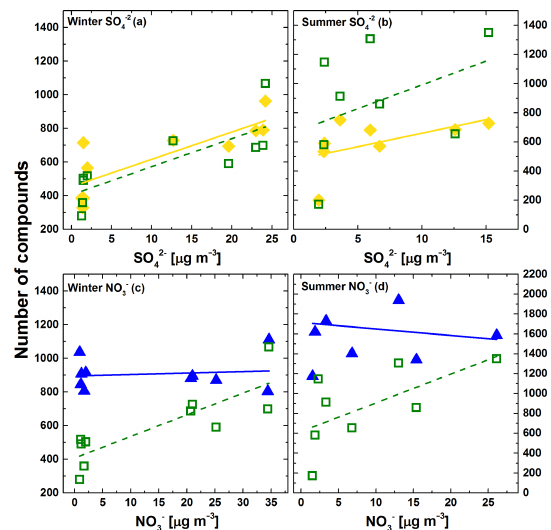
Figure 8. Number of molecular formula with the elemental composition CHOS (yellow diamonds), CHONS (green square) and CHON (blue triangles) plotted against the concentration of (c, d) in the particle phase, analysed via ion (a, b) or NO − SO 2 − 4 3 chromatography. An overview of the correlation parameters can be found in the Supplement (Table